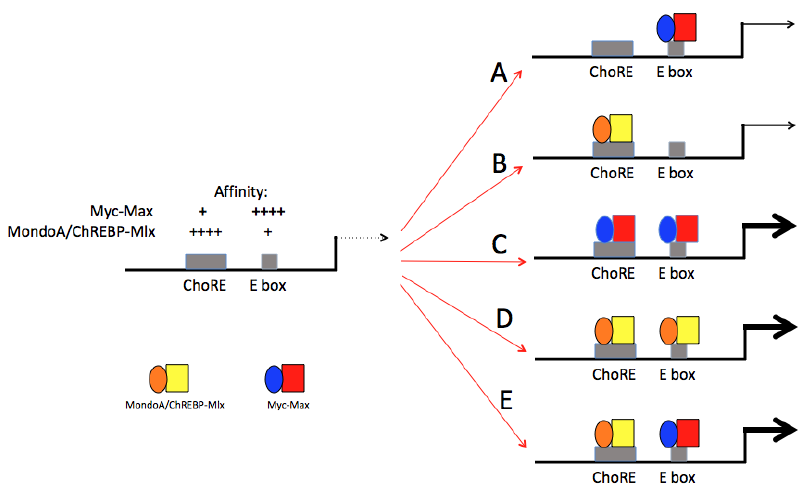
Figure 2. Co-regulation of common target genes by Myc and Mlx Network members. Possible transcriptional scenarios in response to binding by Myc and/or Mlx Network members. On the left, a hypothetical gene bearing an E box that is either of high- or low-affinity for Myc (++++ and +, respectively) (small gray box). It also contains a ChoRE of similar affinities for MondoA/ChREBP-Mlx (large gray box). The gene is expressed at a low basal level in the absence of Myc and MondoA/ChREBP as might occur in quiescent cells maintained in low glucose. ( A ). In a low glucose environment, Myc may be induced in response to a normal proliferative signal. Myc-Max heterodimers bind to the high-affinity E box but not to the ChoRE and activate transcription in a glucose-independent manner. ( B ). In quiescent cells in a high glucose environment, MondoA/ChREBP-Mlx heterodimers enter the nucleus, bind to the high-affinity ChoRE but not to the E-box and activate transcription in a glucose-dependent manner. ( C ). In tumor cells that express excessively high Myc levels, Myc binds to both the high affinity E box and the low-affinity ChoRE. In the latter case, Myc-Max levels may be sufficiently high so as to exclude MondoA/ChREBP-Mlx binding entirely despite their otherwise high affinities for this site and particularly if they are expressed at low levels. Gene expression is now again glucose-independent. ( D ). In quiescent cells in which MondoA and/or ChREBP are particularly high, they may bind to both high-affinity ChoREs and low-affinity E boxes and regulate gene expression in a manner that is now glucose-dependent and Myc-independent. ( E ). In response to a normal proliferative stimulus and high-glucose, the gene is induced to a high level as a result of Myc-Max and MondoA/ChREBP-Mlx heterodimers each binding their respective high-affinity sites. One actual example of such transcriptional fine-tuning involves the TXNIP (thioredoxin- interacting protein) gene, which encodes a member of the α -arrestin family that is negatively